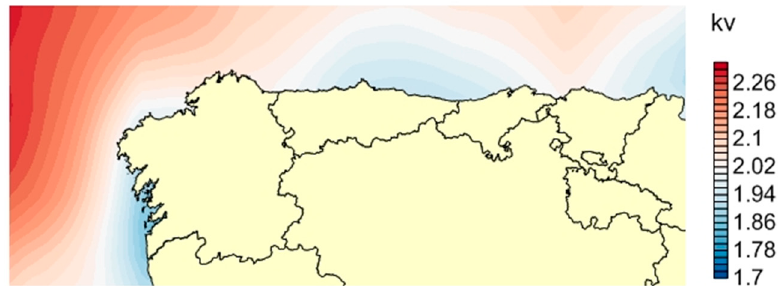
Figure 3. Shape of the offshore wind parameter for the North of Spain.